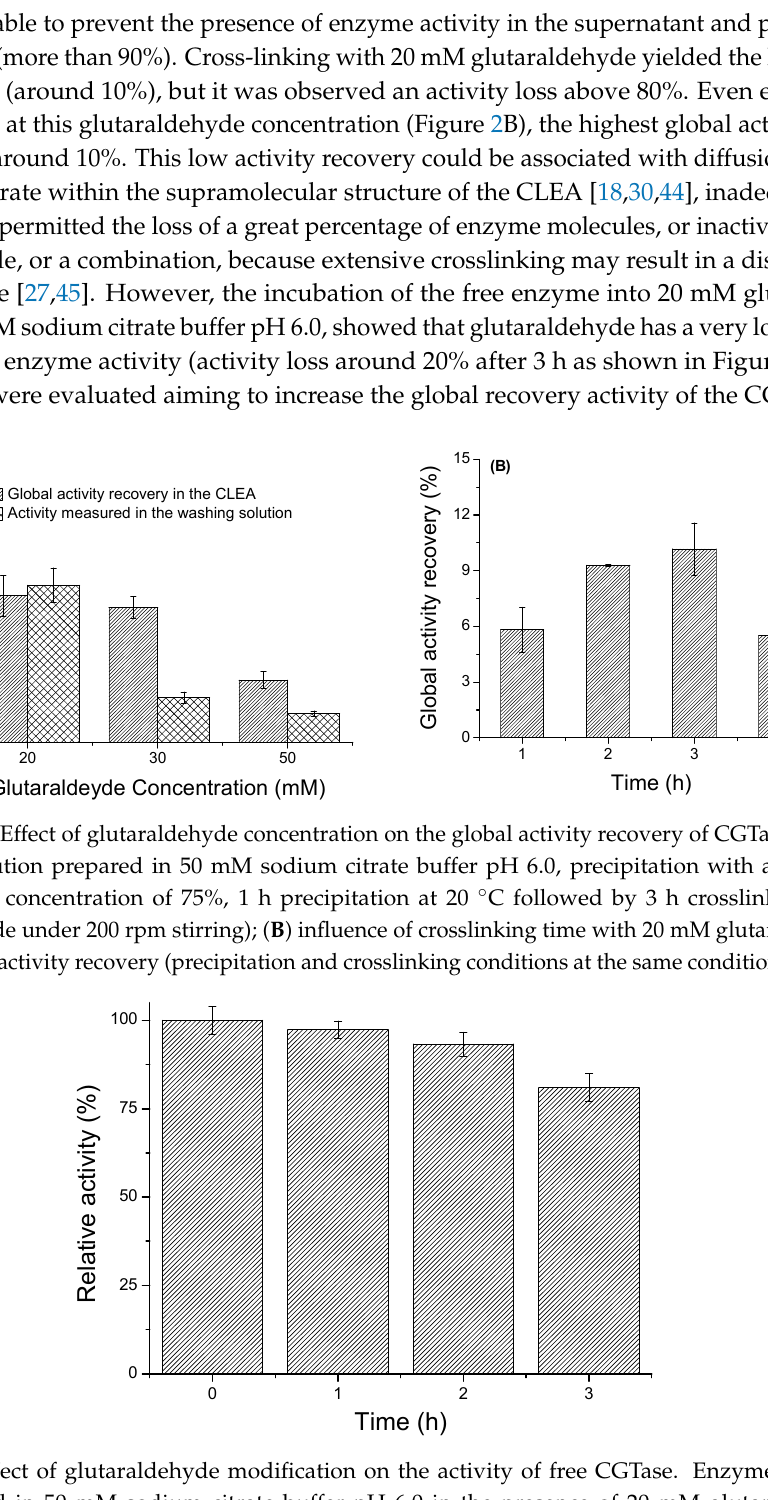
Figure 3. Effect of glutaraldehyde modification on the activity of free CGTase. Enzyme solution was prepared in 50 mM sodium citrate buffer pH 6.0 in the presence of 20 mM glutaraldehyde. Conditions: enzyme concentration of 0.355 mg protein/mL, 20 °C at 200 rpm stirring. The initial activity (11.71 ± 0.46 U/mL) was taken as 100%.